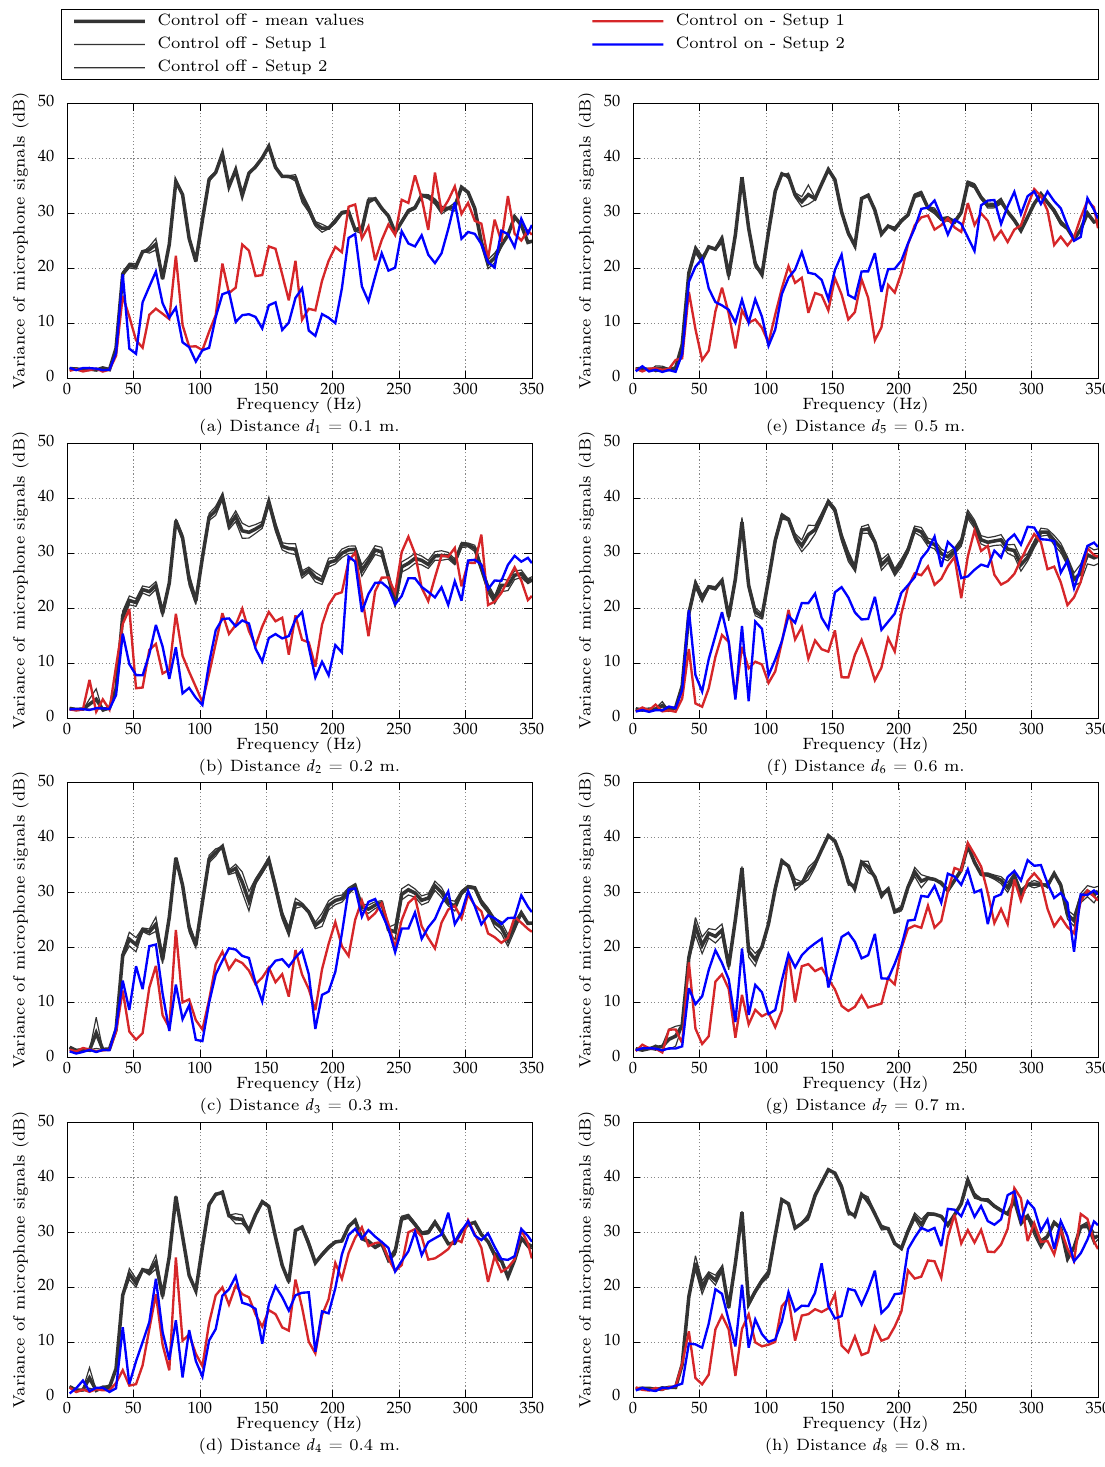
Figure 14. The average variance of the room microphone signals for each of the primary noise tones in the range 1 Hz to 350 Hz with a step of 5 Hz, with and without active control, for both Setup 1 and Setup 2.